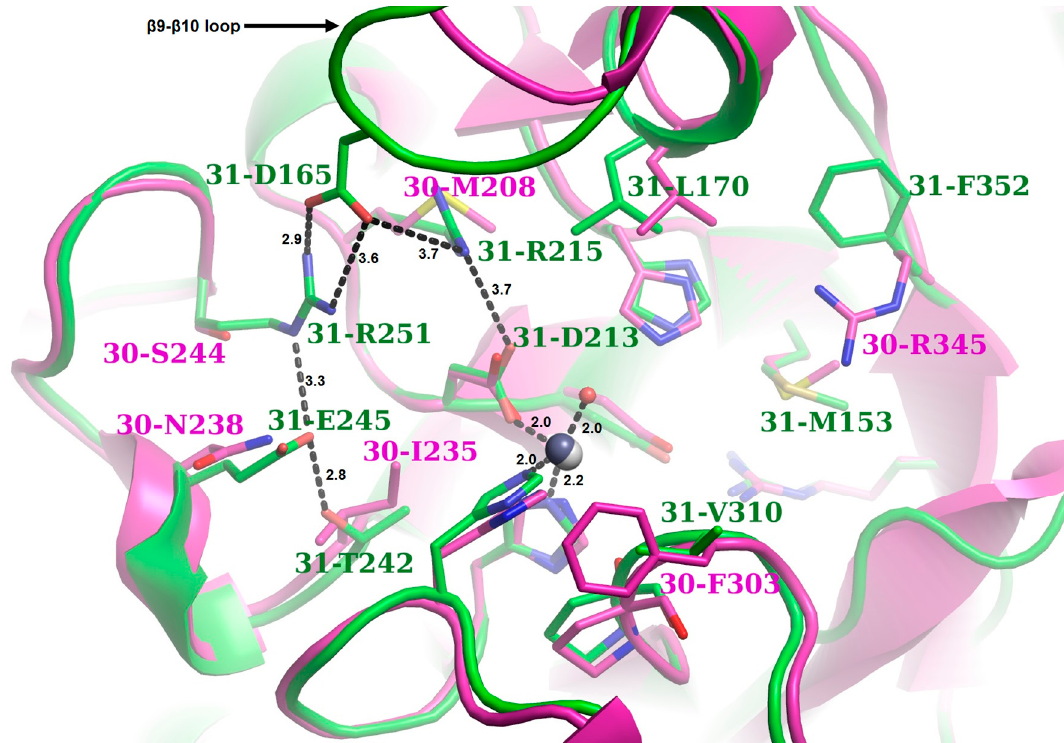
Figure 9. Superposition of the NodB domain containing the binding sites of Ba0331 and Ba0330. Ba0331 is shown in green and Ba0330 is shown in magenta (acquired from PDBIDs: 4V33, 6GO1). The figure is centred on the zinc ion and therefore only the binding site grooves are shown. The residues that either belong directly to an MT1-5 domain or lie within a 5 Å distance from one of these motifs are represented as sticks. The acetate ions were removed for clarity reasons. A black sphere represents the zinc ion in the active site for Ba0331 and a grey sphere shows the zinc ion for Ba0330. The zinc coordination sphere or the interacting network unique in Ba0331 is shown in black dashed lines (distances in angstroms). Only the different residues between Ba0331 and Ba0330 are labelled. A strong interacting network (on the left side of the figure), which corresponds to the upper rim of the binding groove, was observed in Ba0331. In contrast to the Ba0330/Bc0361 deacetylases where the particular side is occupied by hydrophobic or small amino acids, in Ba0331, a number of charged or hydrophilic residues were located. Strong interactions of D165 with positively charged residues stabilize the β 9– β 10 loop to a closed conformation, thus reducing the available volume of the binding groove. On the right side of the figure, which corresponds to the lower side of the binding groove, the presence of M153, L170 and F352 characterized the boundaries as hydrophobic.